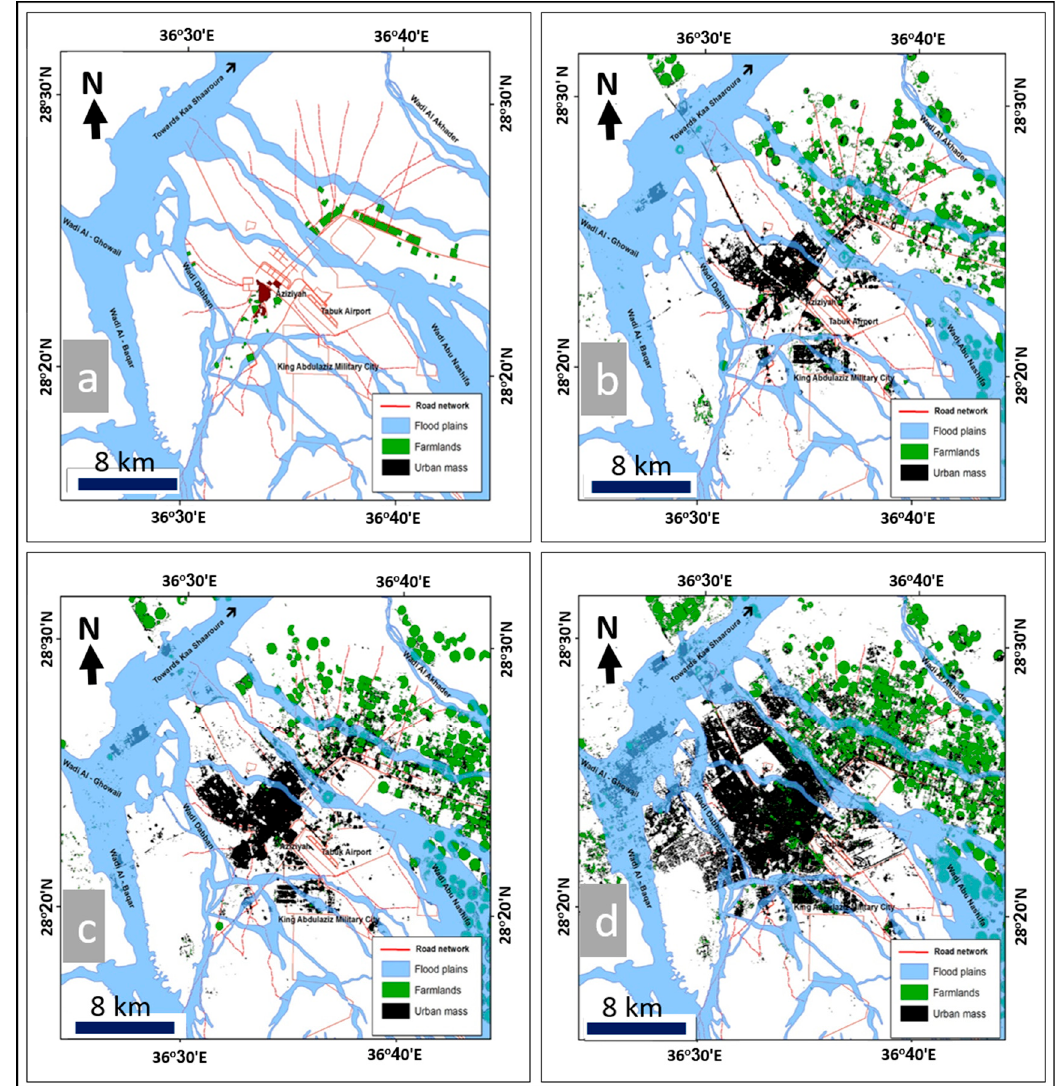
Figure 10. Urban areas of Tabuk City exposed to flooding hazards during the period 1975 to